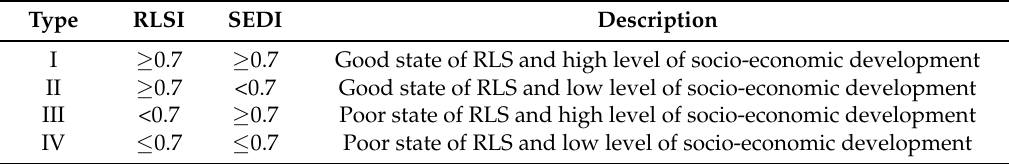
Table 1. Harmonious development types of regional socio-economy and river-lake water systems (RLS).